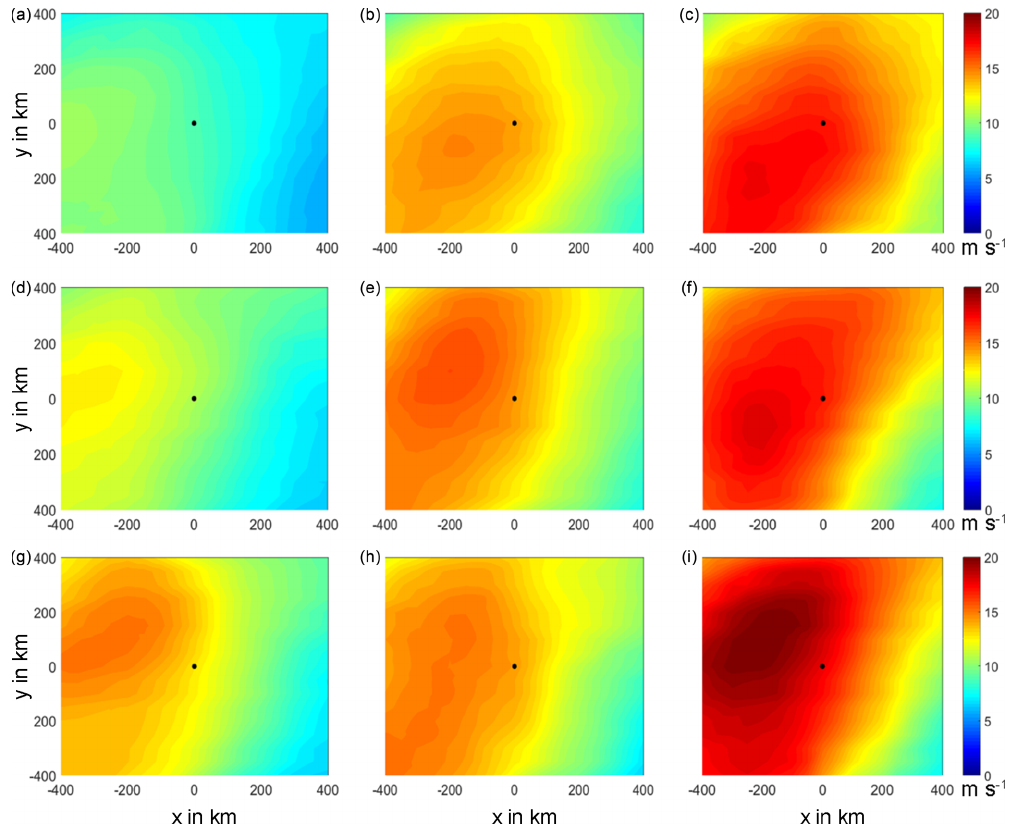
Figure 8. Same as Fig. 7 but for 0–500hPa